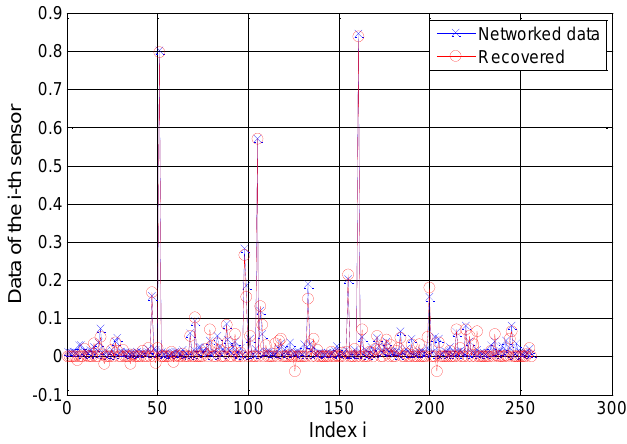
Figure 14. The networked data and its recovery signal.